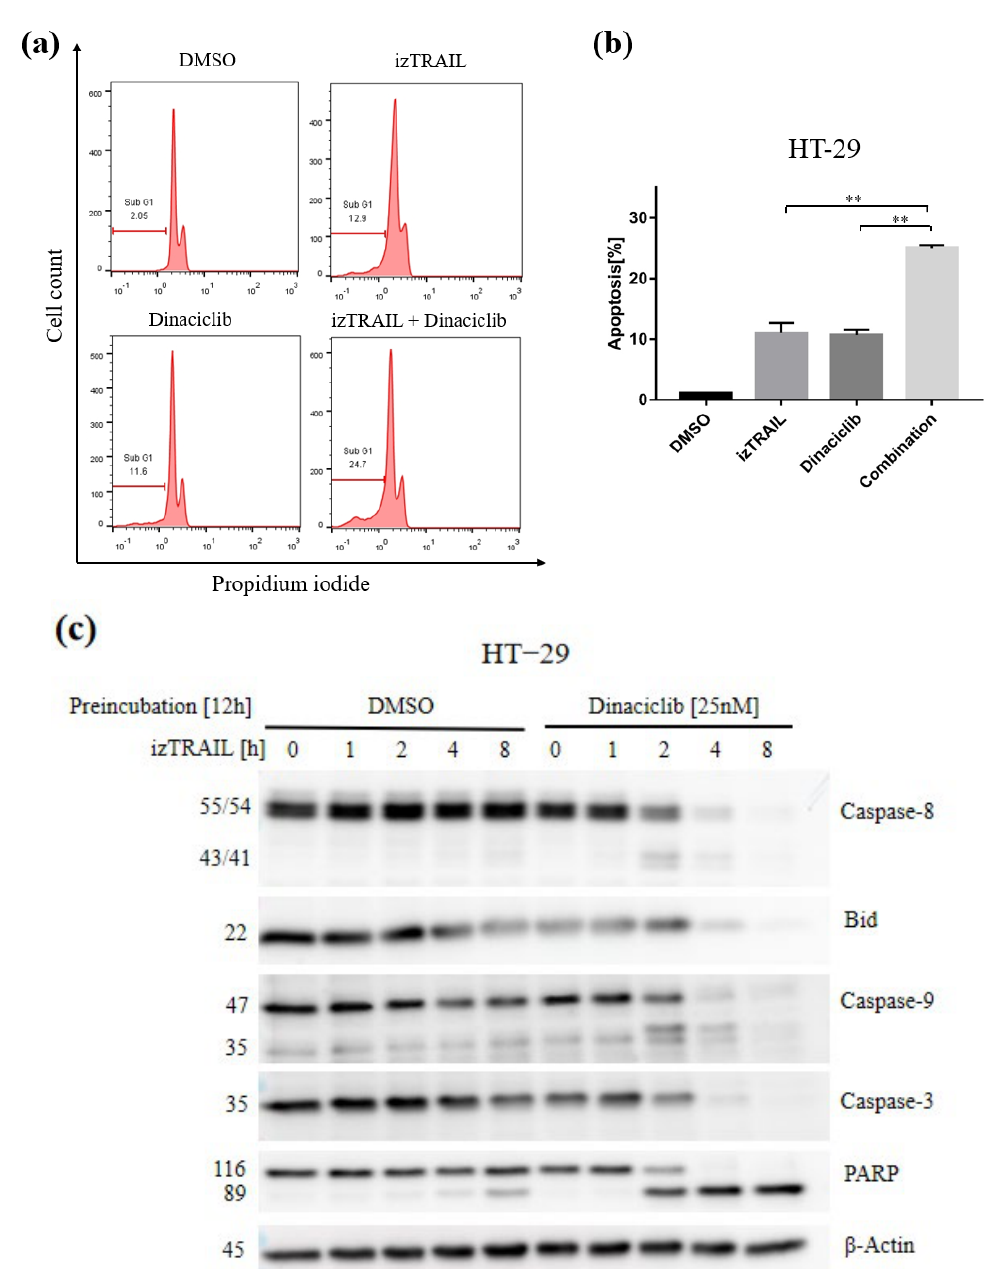
Figure 4. Changes in Sub G1 phase of cell cycle and apoptosis induction in HT−29 cells under the influence of pharmacological CDK9 inhibition plus izTRAIL. ( a ) Analysis of cell cycle Sub G1 phase by propidium iodide (PI) staining for HT−29 cells. Flow cyto metry was used to assess Sub G1 DNA content in the entire cell population. Untreated cells (DMSO) were used as negative control; cells were treated either with TRAIL (10 ng/mL) and Dinaciclib (25 nM) or the combination for 24 h. For each treatment condition, 10,000 events were recorded and cellular debris was excluded from the analysis. Data represent one representative of four independent experiments. ( b ) Data are presented as means ± SD; ** p < 0.01; Student’s t -test. ( c ) HT−29 cells were preincubated with DMSO or Di- naciclib (25 nM) for 12 h and subsequently stimulated with izTRAIL (10 ng/mL) for the indicated periods (0, 1, 2, 4, 8 h). Cells were lysed and subjected to western blotting. Expression levels of Caspase-8, BID, Caspase-9, Caspase-3 and PARP were determinated at the indicated timepoints in control and treated cells. β−actin was used as a loading control. One representative of three inde- pendent experiments is shown.